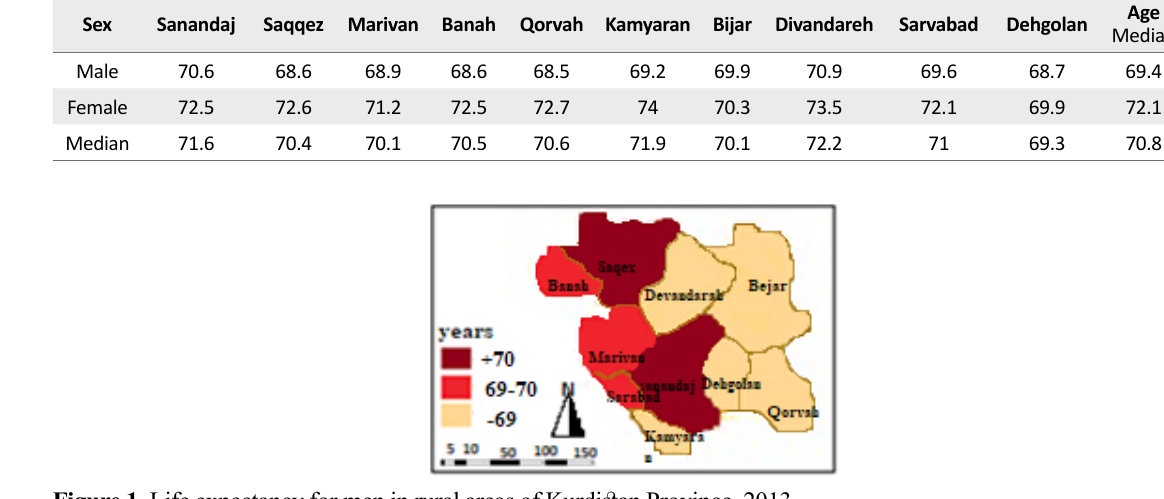
Figure 1. Life expectancy for men in rural areas of Kurdistan Province,